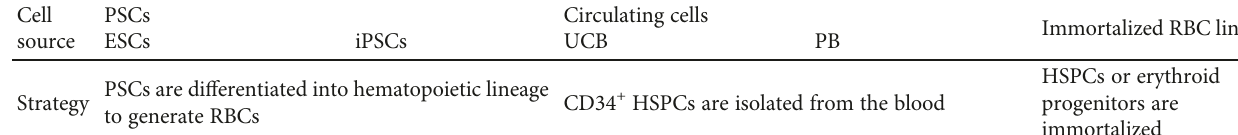
Table 1: Current cell sources and strategies for ex vivo RBC